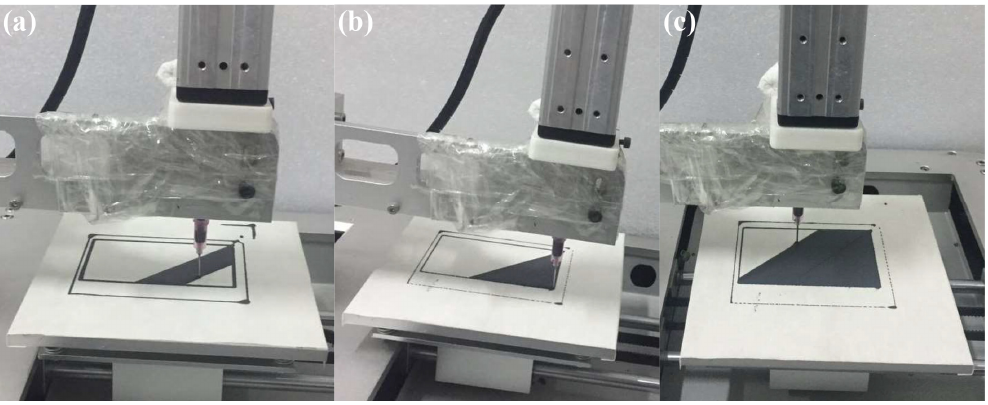
Figure 4. Photograph of the additive manufacturing process, showing the variation in shape of the synthesized materials.